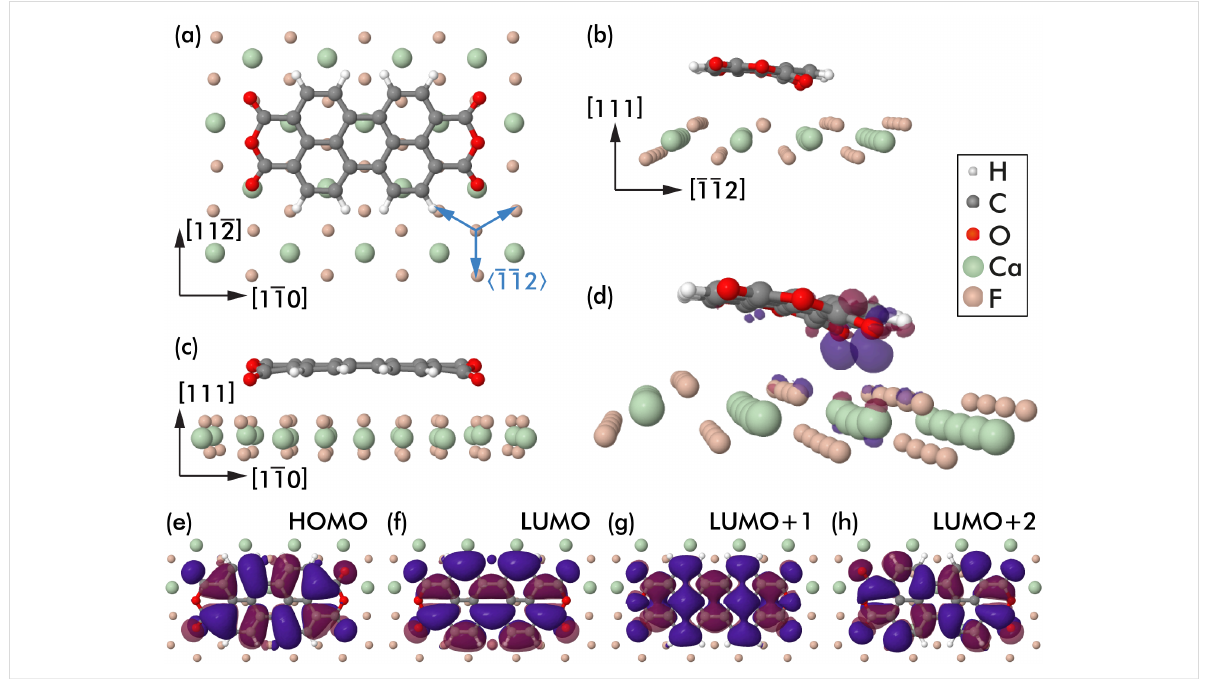
Figure 4: Geometry-optimised adsorption geometry of a single PTCDA molecule on a CaF 2 (111) slap in (a) top view and (b,c) side views. (d) Perspective view of the geometry with isosurfaces at − 0.01 e/Å 3 (red) and 0.01 e/Å 3 (blue) of the electron density difference Δρ